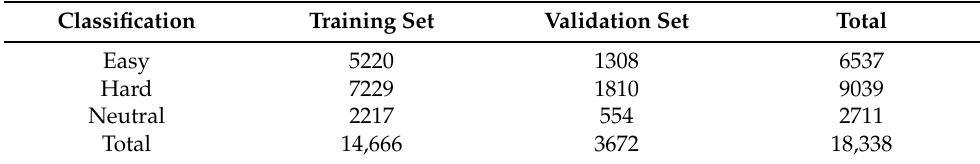
Table 3. Dataset (size 227 × 227) used for the experiments.